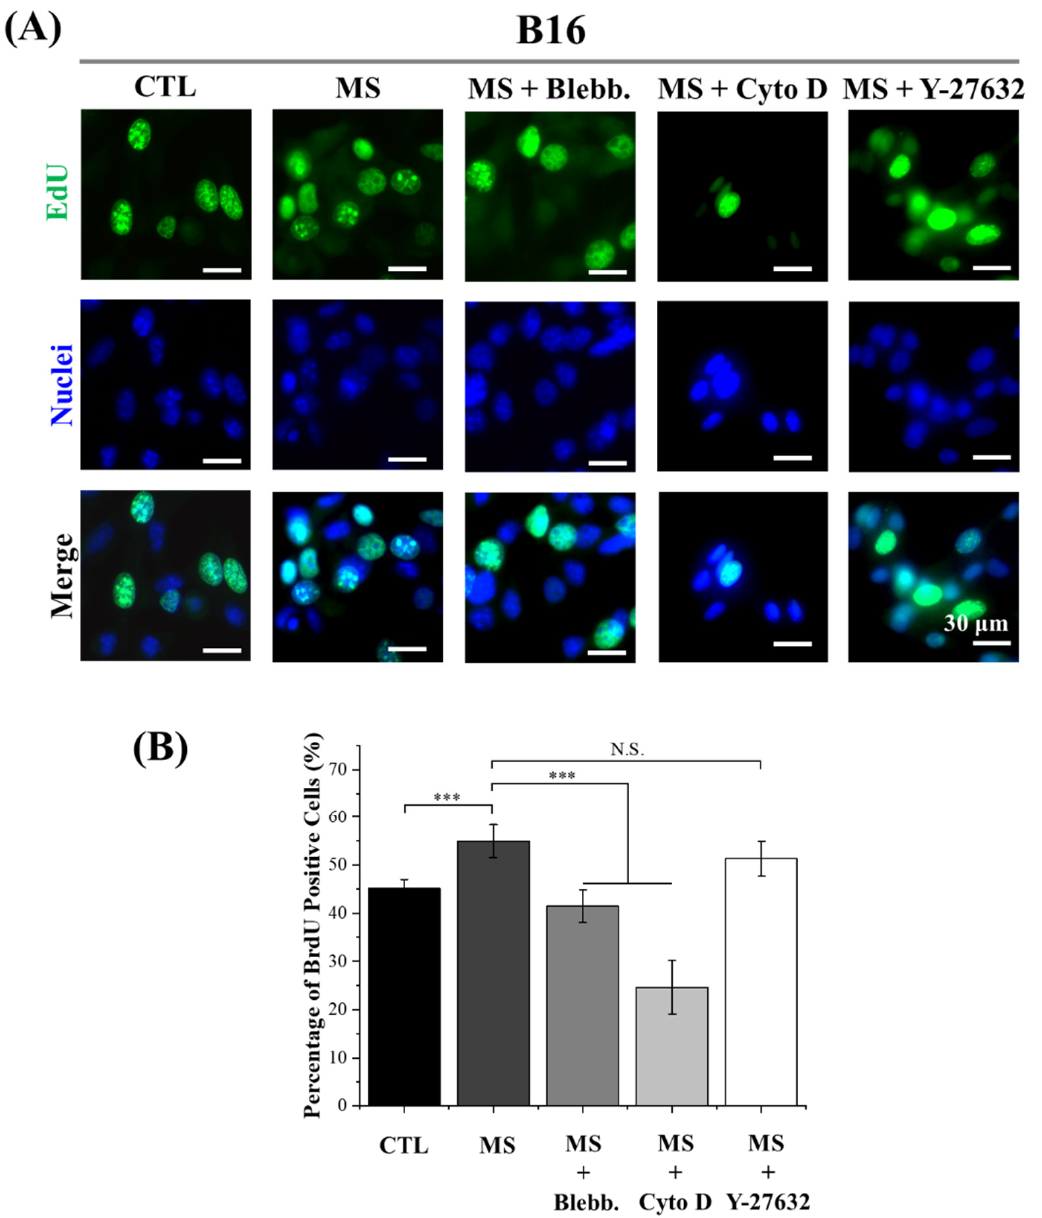
Figure 3. Influence of cyclic straining and inhibitors on the DNA synthesis activity of B16 cells. ( A ) Representative fluorescent images of EdU incorporation. ( B ) Quantitative data of EdU incorporation assay. Data are presented as means ± SDs ( n = 3). *** p < 0.001.